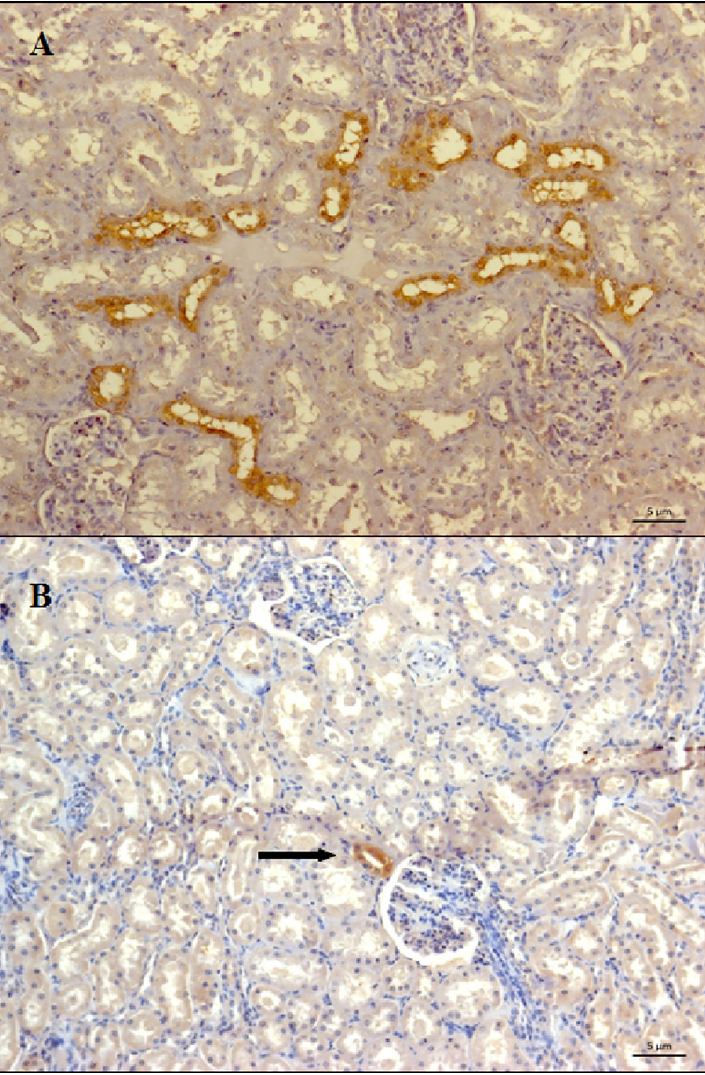
Fig 2. Photomicrographs of renal parenchyma of sheep with anti-protein LipL32 immunolabeling. (A) Mass colonization (many renal tubules marked by field) distributed throughout the cortex. ( B) Isolated tubule labeling in the cortex (arrow) (200x magnification). In both, the Leptospira antigen was labeled in brown in the distal tubular epithelial cells, with non obstructive pattern.